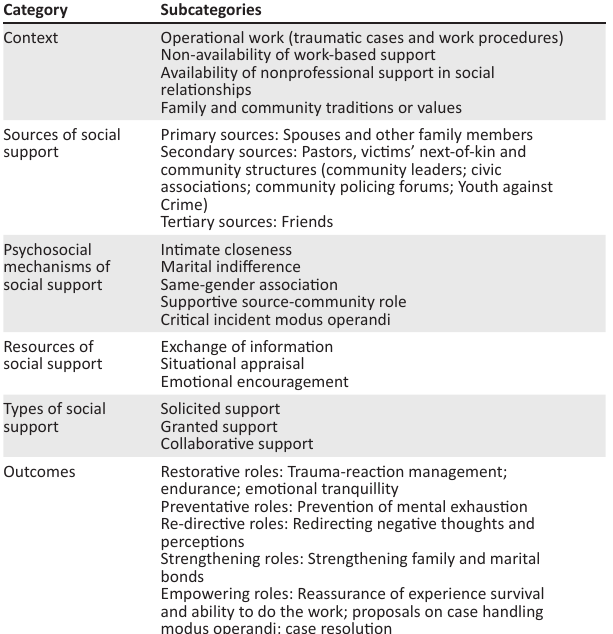
TABLE 1: Concepts of a multifaceted social support network